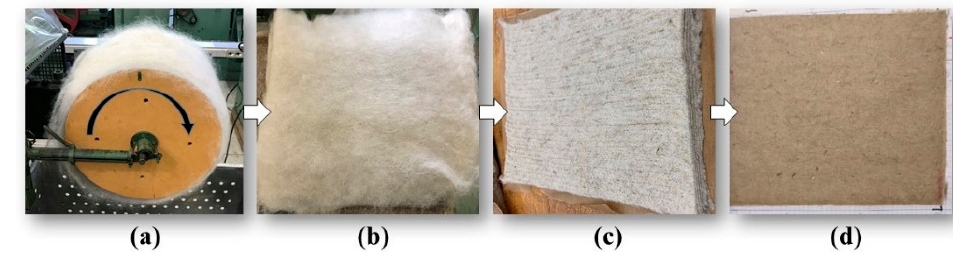
Figure 2. Composites production from carding to compression molding: ( a ) collection of fiber web over a rotating roller; ( b ) Fiber mass of a specific area weight; ( c ) Needled fiber mass (Fiber mat); ( d ) Fiber mat after compression molding, fibers are predominantly oriented in the production direction indicated by arrows.